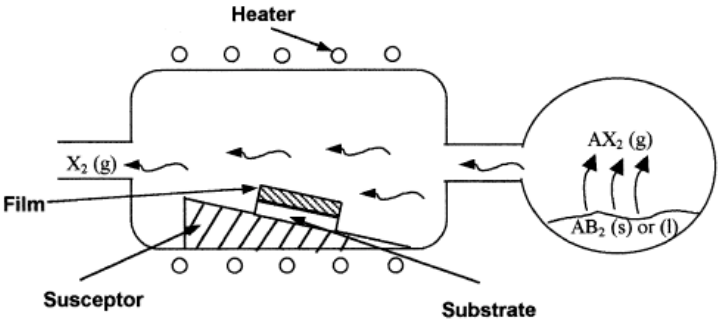
Figure 1. A schematic diagram of the chemical vapor deposition (CVD) coating [6]. Reprinted with permission from [6]; 2003 Elsevier.